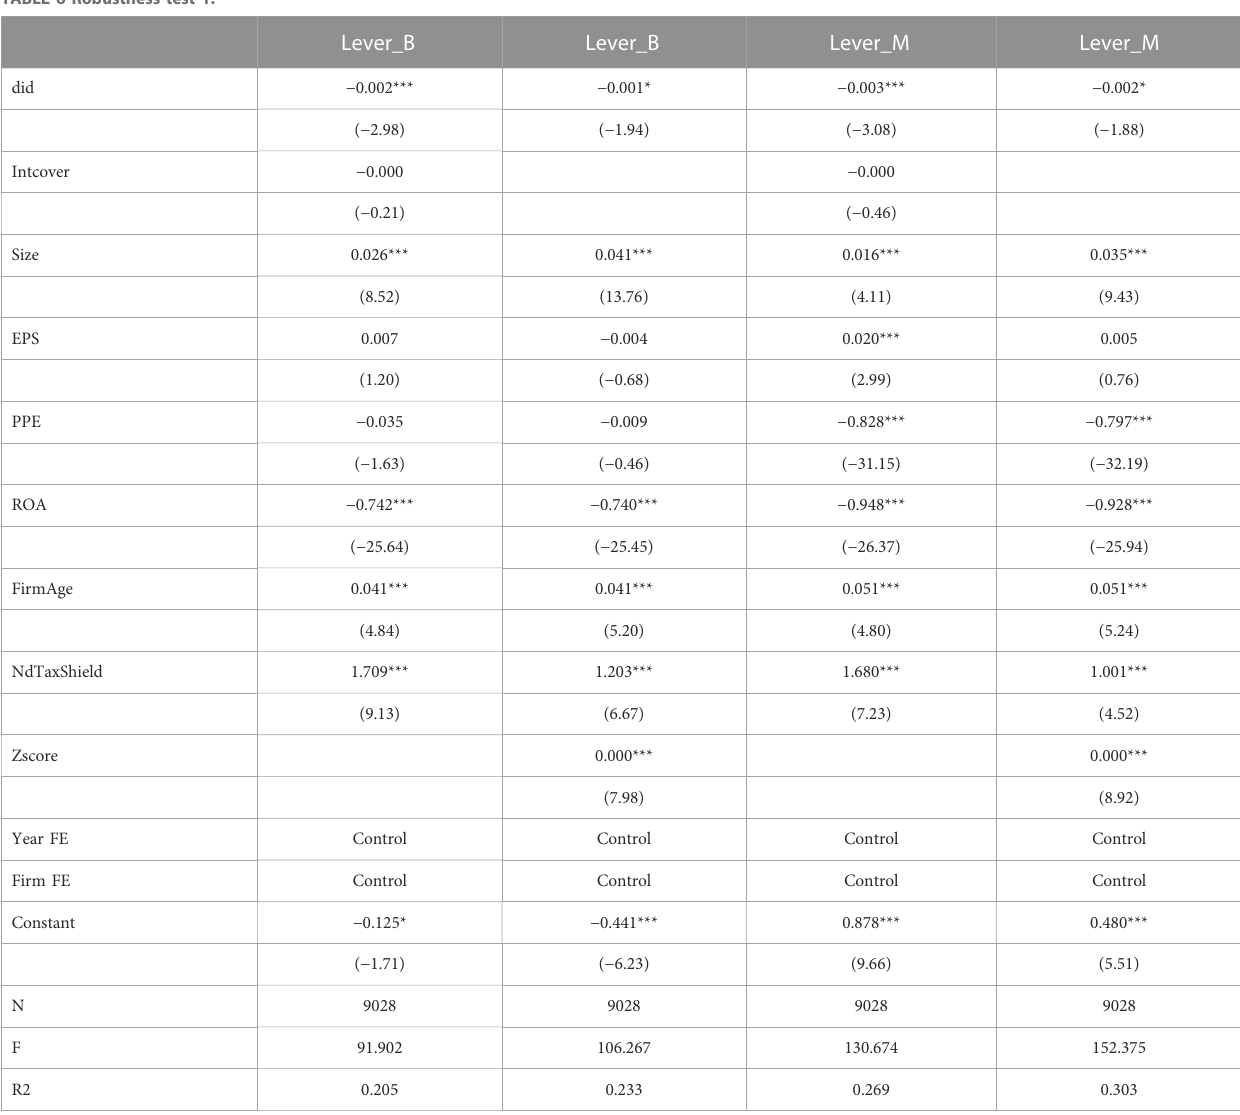
TABLE 6 Robustness test